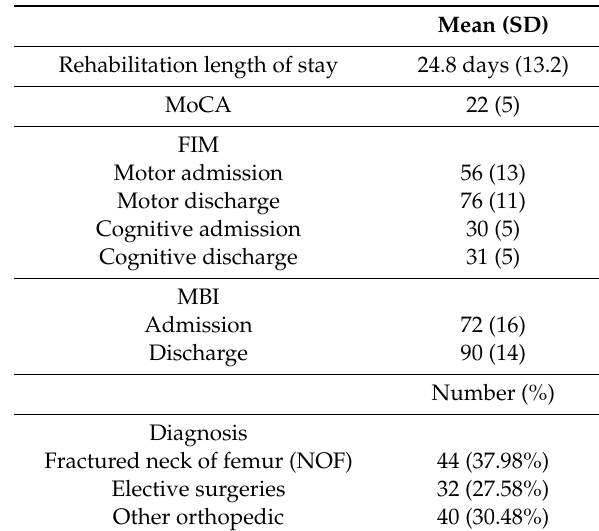
Table 1. Clinical characteristics of patients.